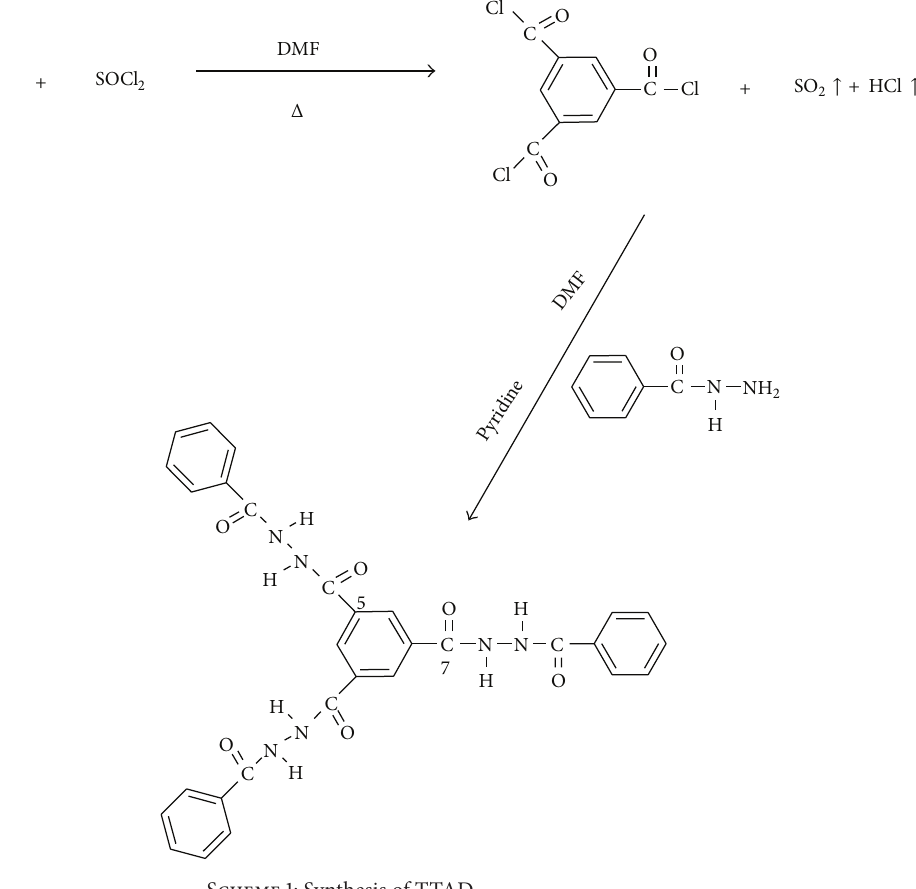
Scheme 1: Synthesis of TTAD.